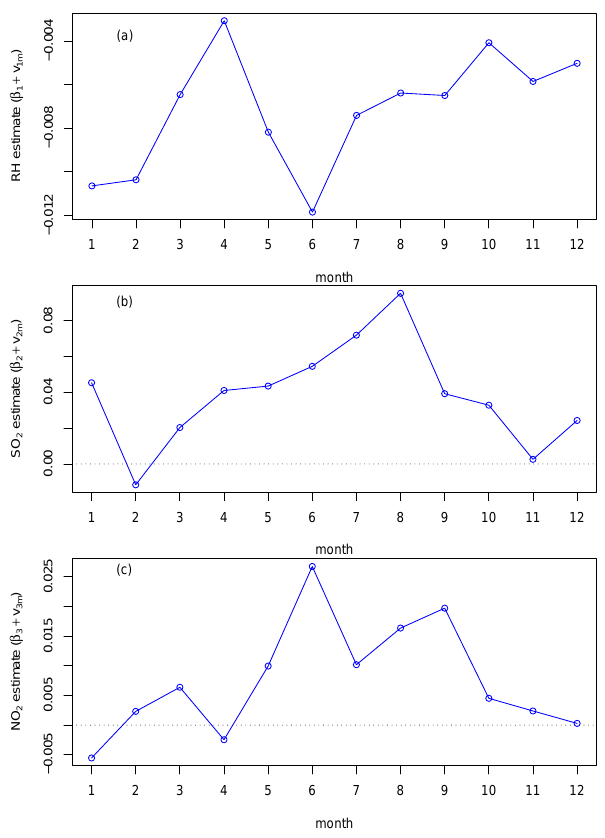
Fig. 2. Seasonal estimates of (a) RH, (b) SO 2 , and (c) NO 2 for the combined dataset. Note that the estimates of different parameters are not comparable, since the values of the variables are not